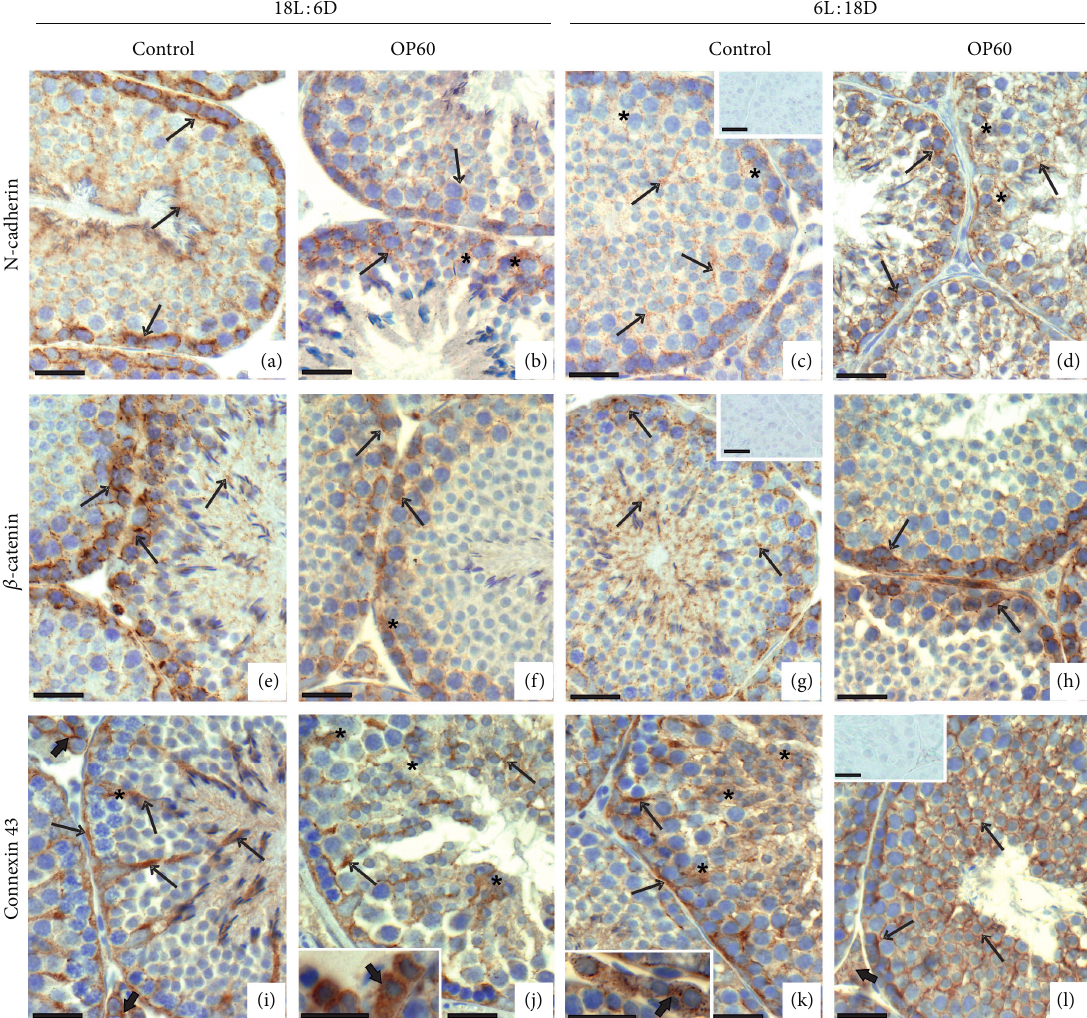
Figure 1: Immunohistochemical localization of N-cadherin (a)–(d), 𝛽 -catenin (e)–(h), and connexin 43 (Cx43) (i)–(l) in the testes of bank voles kept in long (18L:6D) or short (6L:18D) photoperiod treated with vehicle (control) or 4- tert -octylphenol for 60 days (OP60). Scale bars represent 20 𝜇 m. (a)–(d) Immunohistochemical localization of N-cadherin. (a) In control 18L: 6D males strong, linear staining at the region of blood-testis barrier and discrete punctuate staining in the adluminal compartment is observed (arrows). (b) Reduced intensity and delocalization of the staining following OP60 treatment (arrows). (c) In control 6L:18D voles weak staining extends through much of the epithelium (arrows). (d) In OP60 tubules enhanced staining is visible (arrows). No signal was detected when anti-N-cadherin antibody was omitted (insert in (c)). (e)–(h) Immunohistochemical localization of 𝛽 -catenin. (e) Typical distribution of 𝛽 -catenin signal is seen in the basal compartmentofseminiferousepitheliumandattheregionsofmembraneappositionofadjacentSertolicellandelongatedspermatids(arrows) in the testes of control 18L:6D males. (f) Note decreased intensity of the staining at the blood-testis barrier site (arrows) and loss of the signal in the adluminal compartment in OP60 voles. (g) In the tubules of 6L: 18D animals weak staining is dispersed in the seminiferous epithelium (arrows). (h) Increased staining intensity in the basal compartment in OP60 males (arrows). No signal was detected when anti- 𝛽 -catenin antibody was omitted (insert in (g)). (i)–(l) Immunohistochemical localization of connexin 43 (Cx43). (i) In the tubules of control 18L: 6D males Cx43 is seen predominantly between Sertoli cells and spermatogonia or pachytene spermatocytes and in the cytoplasm of some Sertoli cells as well as at Sertoli cell-spermatid junctions (arrows). Note strong linear staining between Leydig cells (small arrows). (j) In OP60 males Cx43 signal is localized in the form of irregular lines or distinct foci between the cells (arrows) and sometimes in the cytoplasm of Sertoli cells (asterisks). Cytoplasmic staining is present in most Leydig cells (small arrow; insert). (k) In the tubules of 6L:18D voles irregular and discontinuous signal is visible (arrows). Frequently, the staining is confined to the cytoplasm of the cells (asterisks). In Leydig cells, staining of moderate intensity is detected in the cytoplasm (small arrow; insert). (l) Note altered staining pattern in OP60 animals; signal visible at the entire surfaces of Sertoli and germ cells (arrows). Very week staining in Leydig cell cytoplasm (small arrow). No signal was detected when anti-Cx43 antibody was omitted (insert in